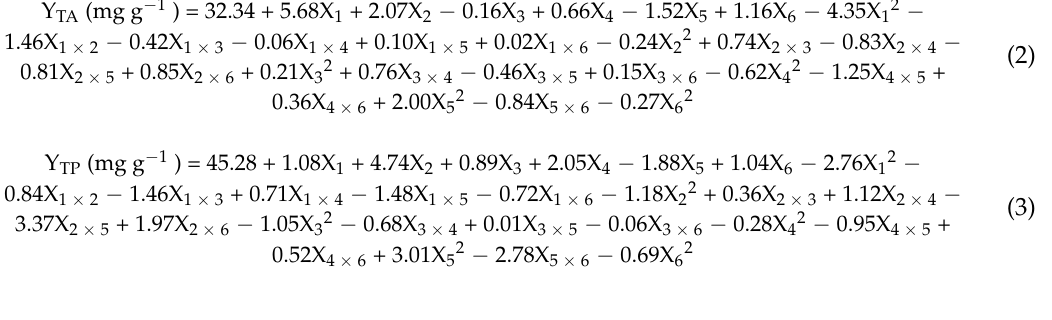
Table 2. Analysis of variance (ANOVA) of the quadratic model adjusted to the extraction yield. ( A ) Total anthocyanins; and, ( B ) Total phenolic compounds.